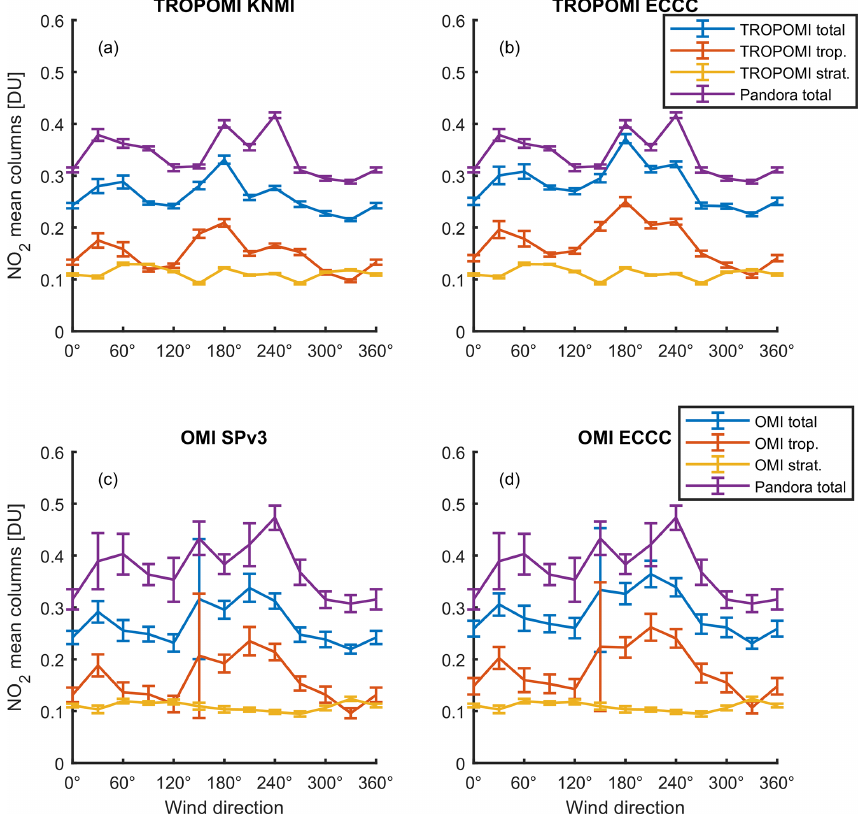
Figure 9. TROPOMI, OMI, and coincident Pandora measurements from Downsview, binned by wind direction. TROPOMI data in (a) are from KNMI products and in (b) are from ECCC products (2018). OMI data in (c) are from NASA SPv3 products and in (d) are from ECCC products (2015–2018). Blue, red, and yellow lines are TROPOMI or OMI total, tropospheric, and stratospheric columns. Purple lines are Pandora total columns. Error bars are the standard error of the mean.